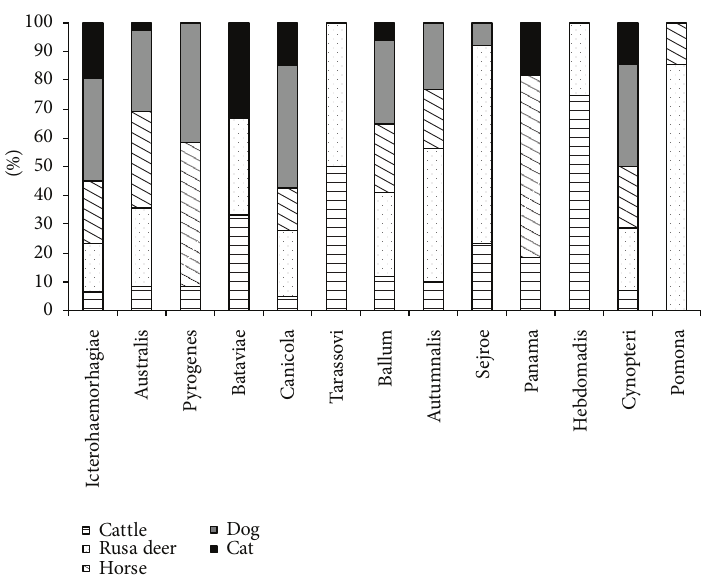
Figure 3: Distribution of animal hosts by